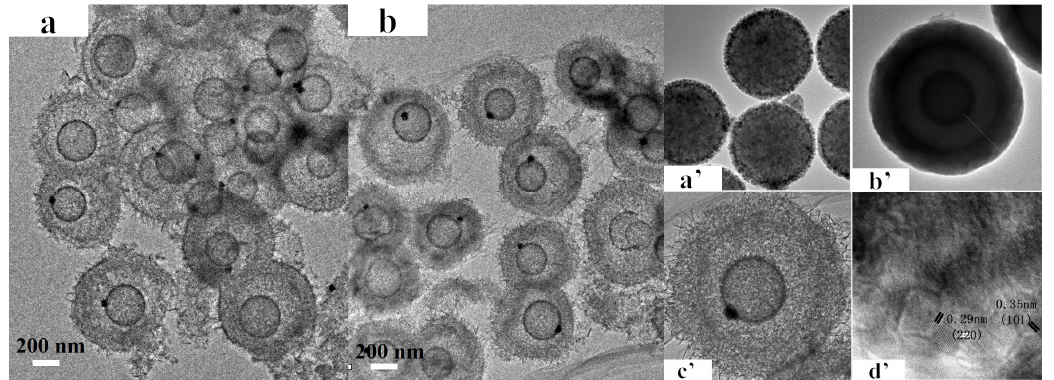
Figure 4. ( a , b ) the images of non-stacked γ -Fe 2 O 3 /C@TiO 2 ; ( a’ – c’ ) of the process of catalyst prepara- tion, and ( a’ ) the image of SiO 2 @ γ -Fe 2 O 3 /C; ( b’ ) the image of SiO 2 @ γ -Fe 2 O 3 /C@SiO 2 @TiO 2 ; ( c’ ) the image of a single sphere of non-stacked γ -Fe 2 O 3 /C@TiO 2 ; ( d’ ) HRTEM images.